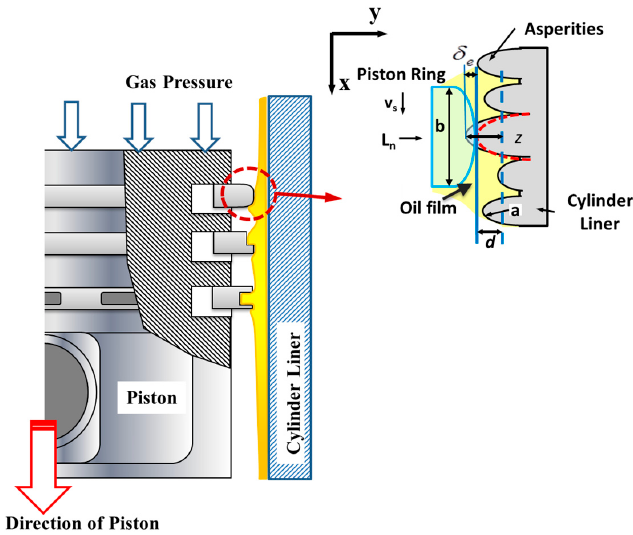
Figure 1. The schematic of asperity–asperity collisions between the piston ring and cylinder liner surfaces.